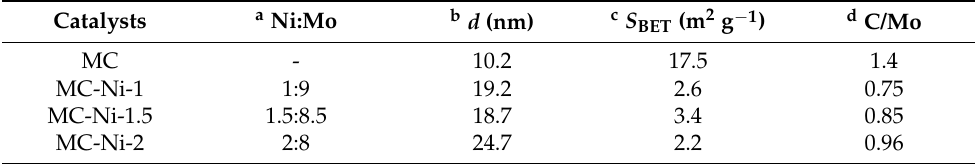
Table 1. Physical properties of the